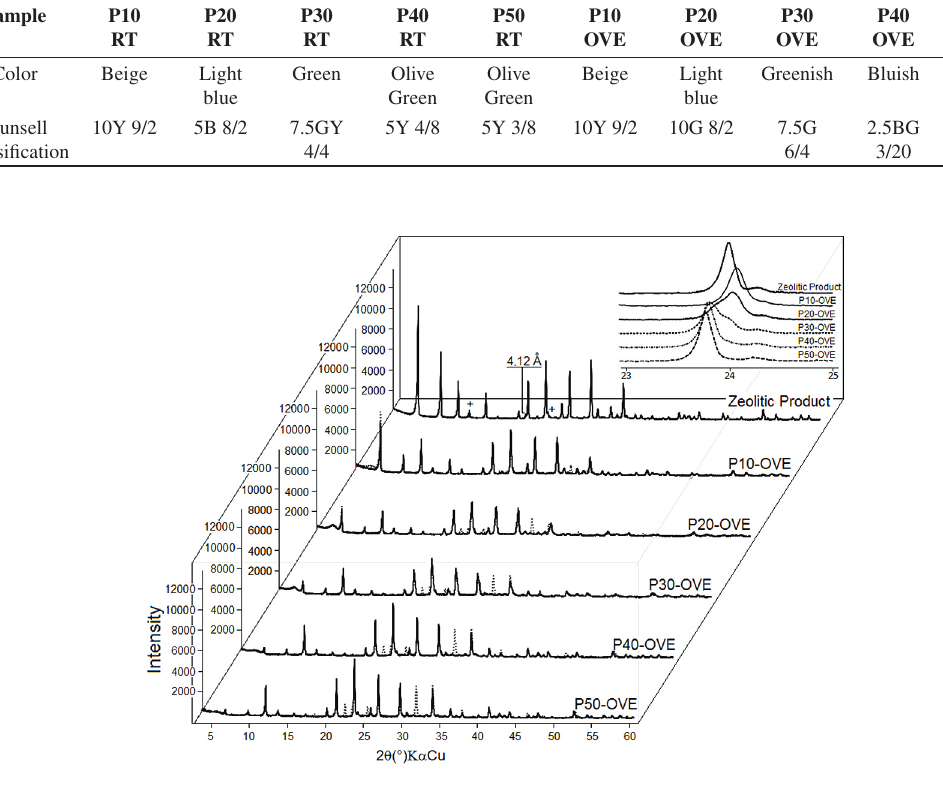
Figure 2. Diffraction patterns of zeolitic product and OVE series pigments. Table 3. Chemical analysis of zeolitic